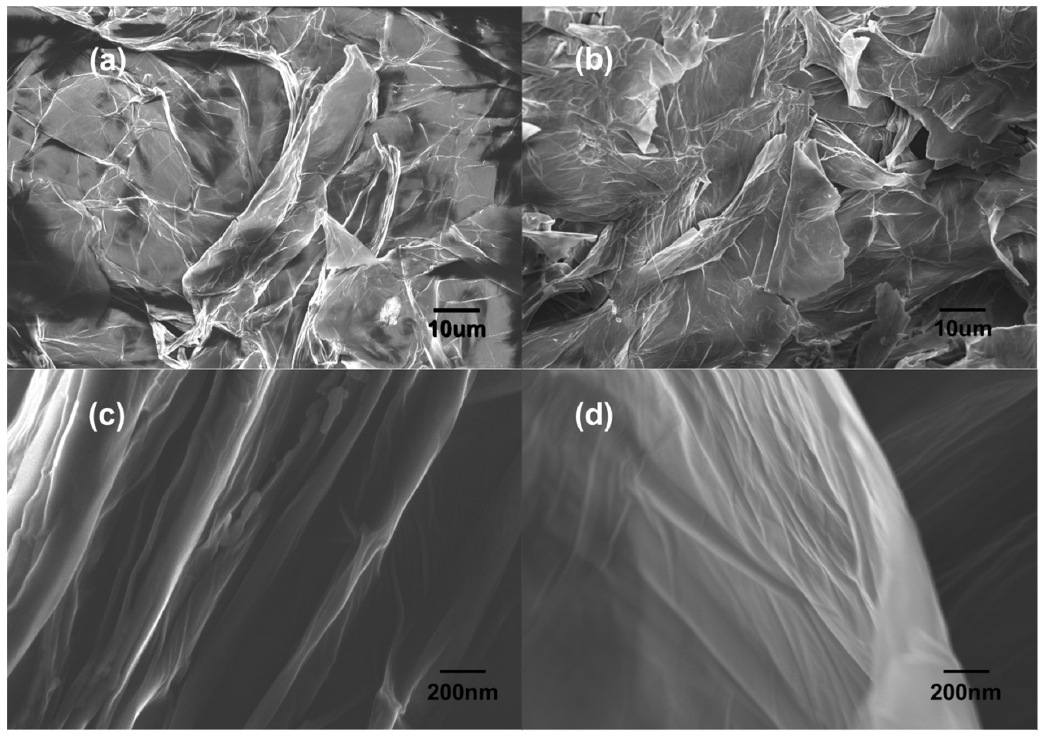
Figure 1. SEM images of GO ( a , c ) and TA/GO ( b , d ).